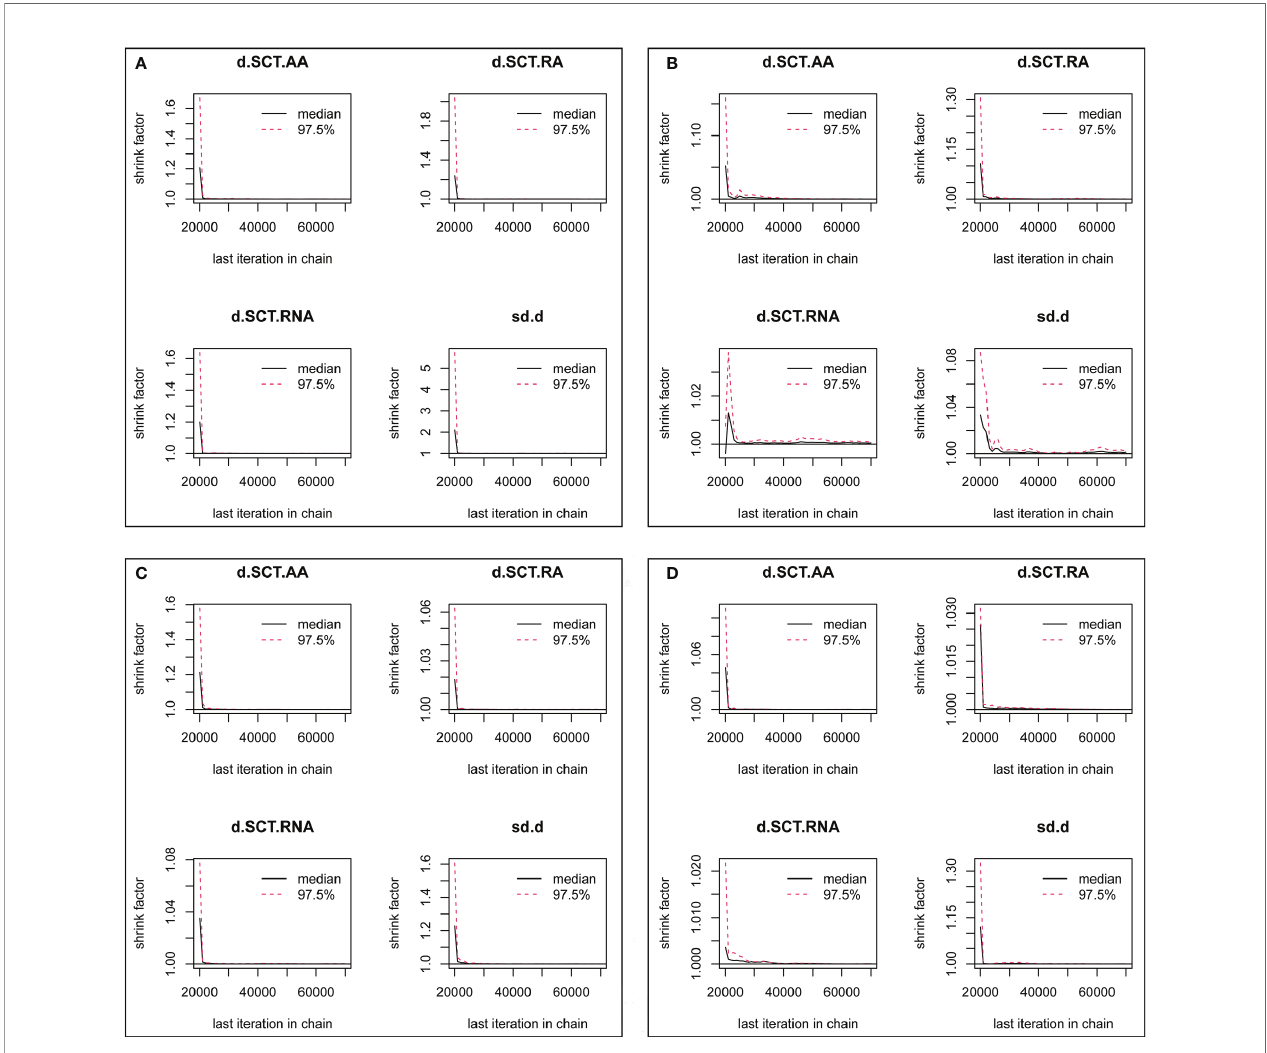
FIGURE 5 | Convergence assessment based on gelman plot for each outcome. (A) Disease-free survival, (B) overall survival, (C) any adverse events, and (D) grade 3 – 4 adverse events. AA, addition of capecitabine to adjuvant chemotherapy; RA, replacement of capecitabine to adjuvant chemotherapy; RNA, replacement of capecitabine to neoadjuvant chemotherapy; SCT, standard